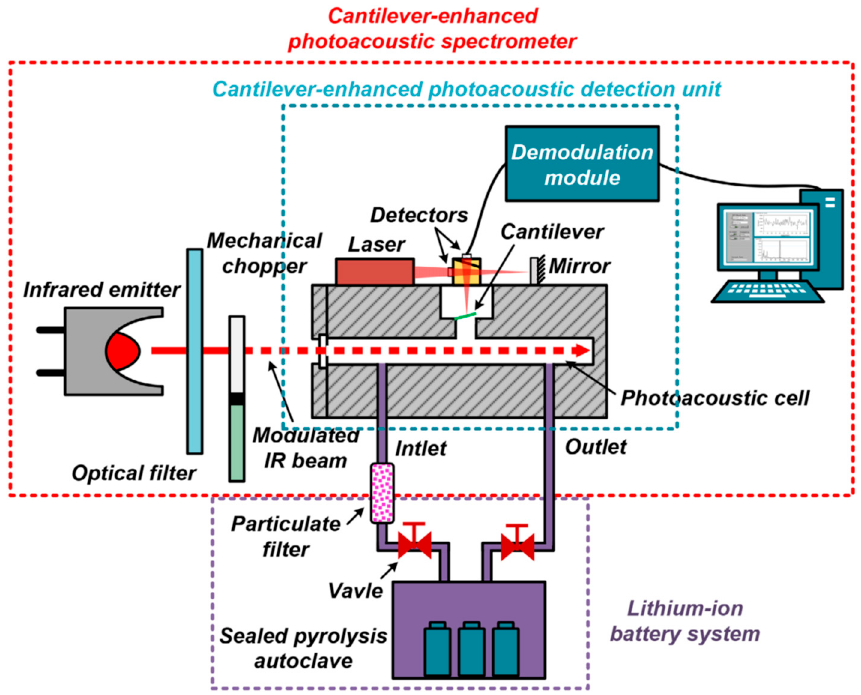
Figure 9. Cantilever-enhanced photoacoustic spectrometer ba tt ery TR warning system [106].